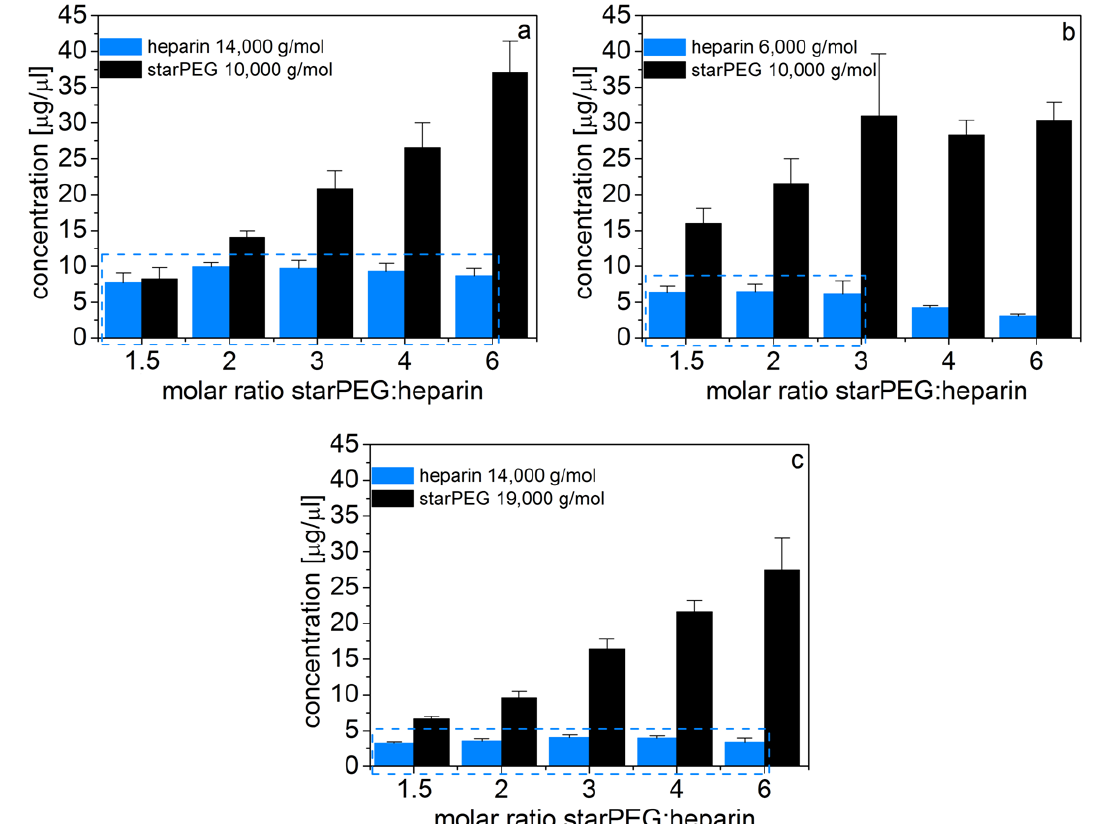
Figure 3. Composition of the swollen starPEG-heparin hydrogels made from ( a ) 10,000 g/mol starPEG and 14,000 g/mol heparin, ( b ) 10,000 g/mol starPEG and 6,000 g/mol heparin, ( c ) 19,000 g/mol starPEG and 14,000 g/mol heparin relative to the starPEG to heparin ratio in the polymer